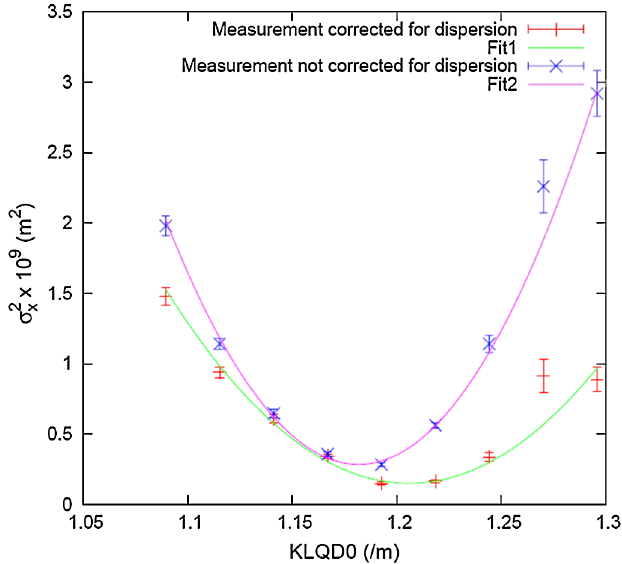
FIG. 7. (Color) Horizontal beam size squared measured at the post-IP wire scanner in May 2009 as a function of QD0 strength. Blue crosses are before and red crosses are after correcting for the measured horizontal dispersion. Green and pink lines are the corresponding parabolic fits. The shift in abscissa between corrected and uncorrected parabolas is due to anomalous hori- zontal